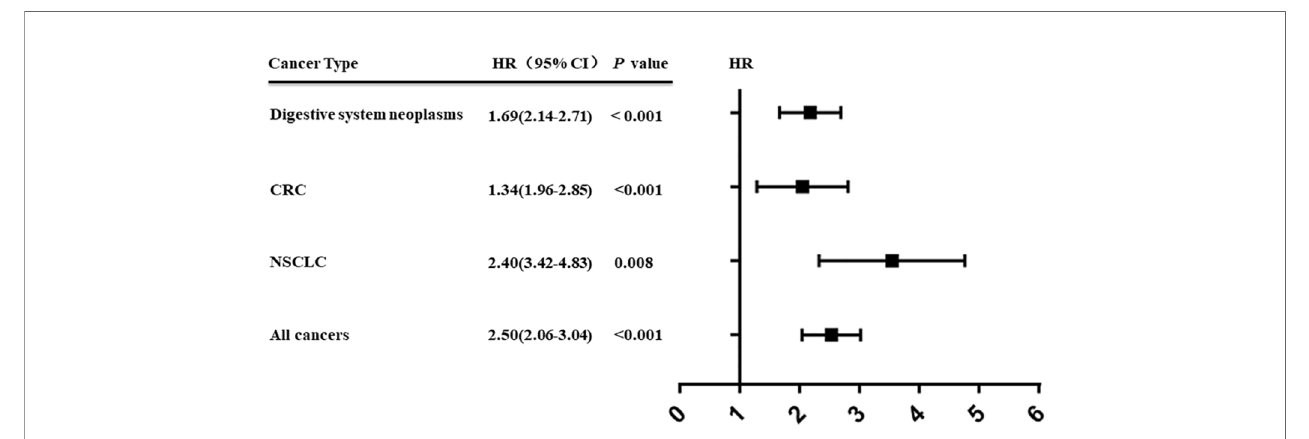
FIGURE 3 | High expression of CDR1as indicates poor prognosis of tumor.